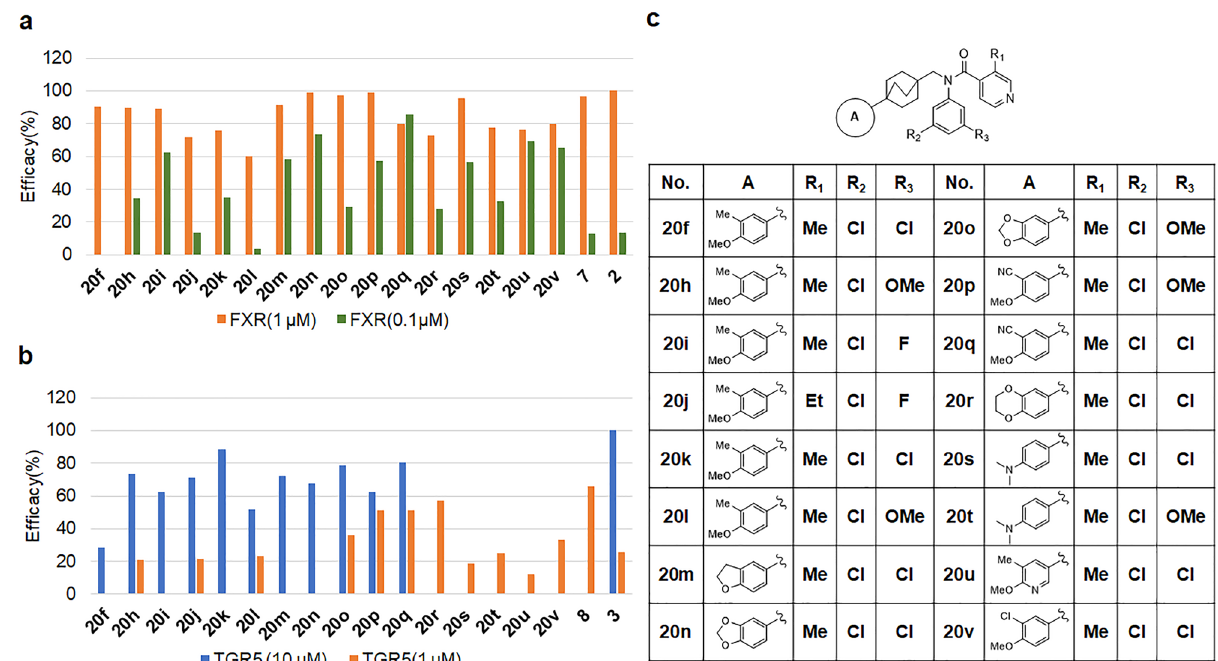
Figure 4. ( a ) FXR agonist activity of bicyclo[2.2.2]octane-isonicotinamide derivatives 20f – 20v . Efficacy(%); % vs OCA 1 µM as 100%, OCA; 100% (1 µM), 13.3% (0.1 µM); ( b ) TGR agonist activity of bicyclo[2.2.2]octane- isonicotinamide derivatives 20f – 20v . Efficacy(%); % vs INT-767 10 µM as 100%, INT-767 100% (10 µM), 25.5% (1 µM), 1.7% (0.1 µM). ( c ) Structures of bicyclo[2.2.2]octane-isonicotinamide derivatives 20f - 20v